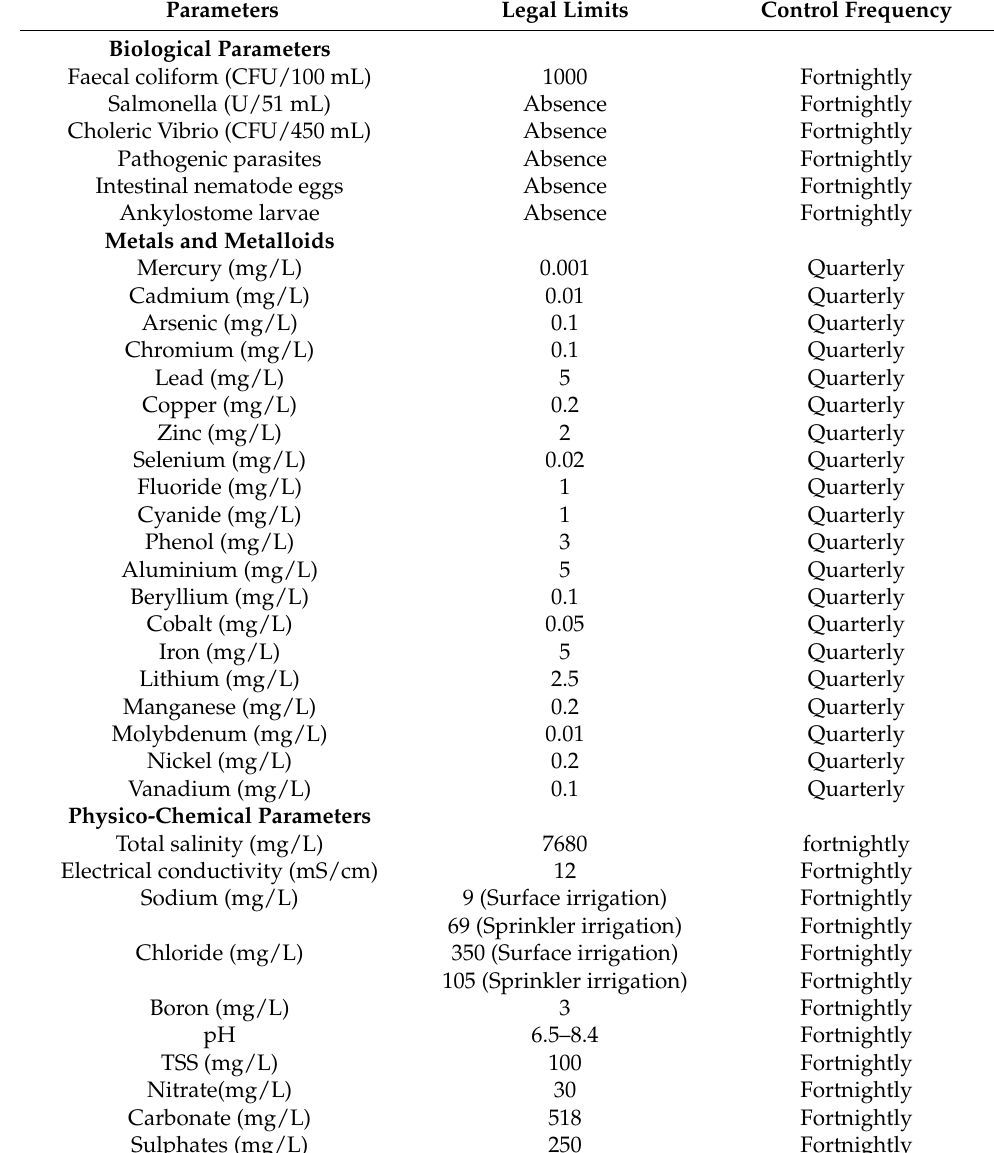
Table 3. Moroccan guidelines for the quality of irrigation